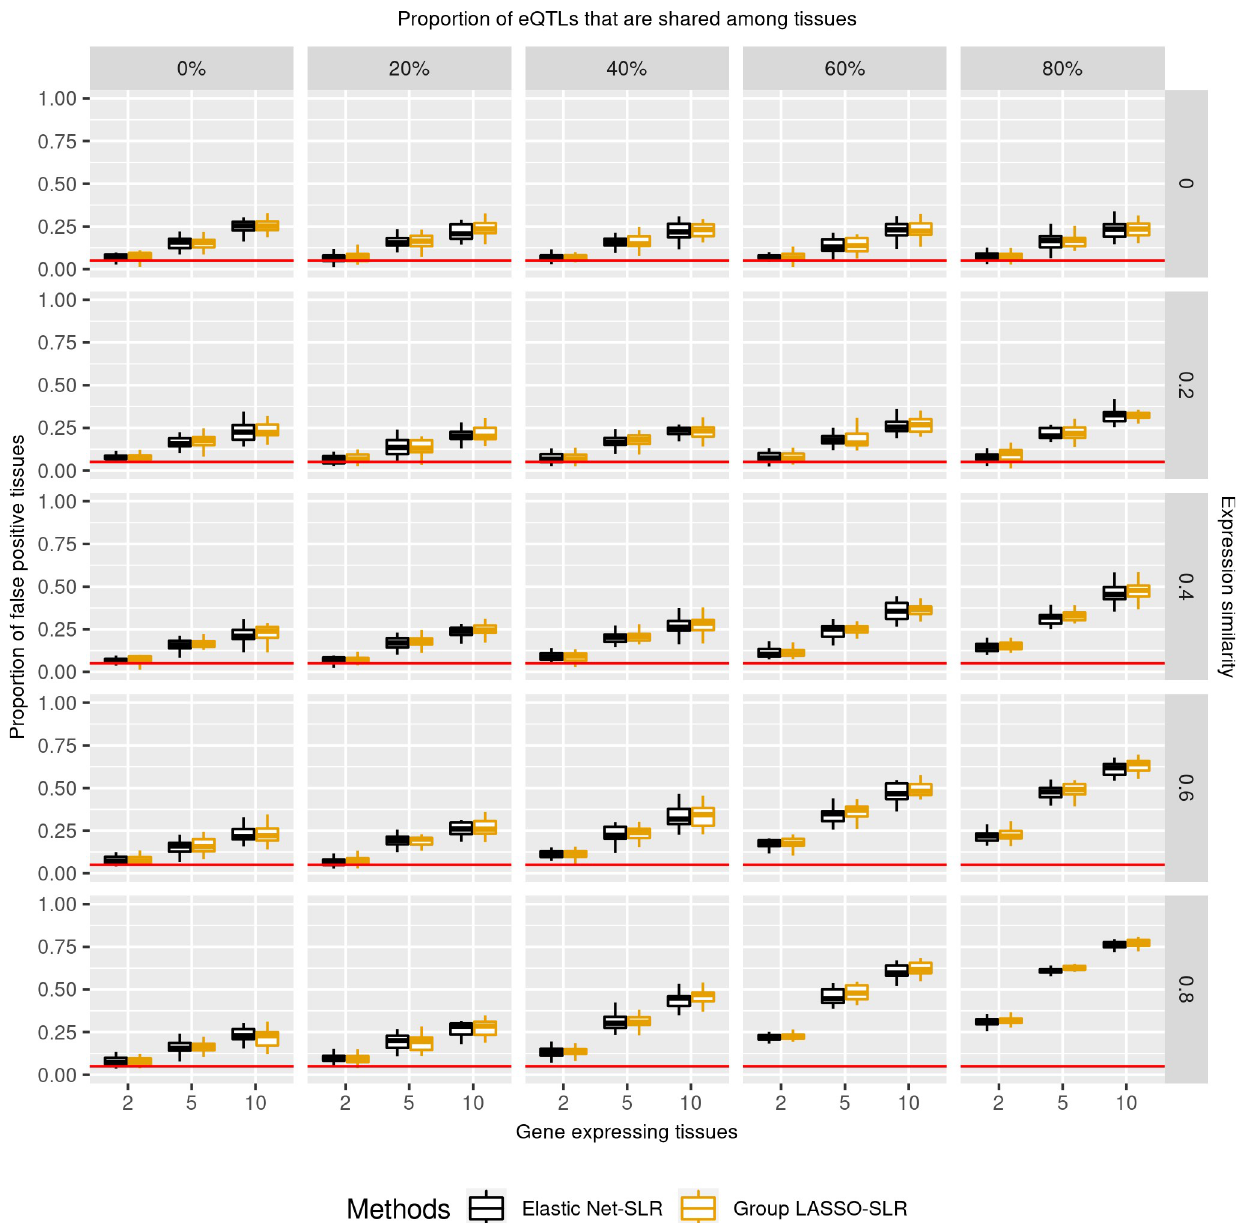
Fig 4. False positive rates of tissues among statistically significant results. False positive rates were the proportion of significant associations found in trait-irrelevant tissues amongst all significant results. Association p-values were controlled for the number of genes and tested tissues. X-axis is the number of gene-expressing tissues. Each column stands for the proportion of eQTLs that are shared among tissues for a gene. Each row is the similarity of gene expression profiles across tissues which is estimated by correlation. Moving from the top left to the bottom right is a gradient spectrum from tissue-specific genes to broadly expressed genes. Colors represent different TWAS methods and y-axis is the false positive rate of tissues among statistically significant results. Single-tissue TWAS wrongly identified 5% and 77% trait-irrelevant tissues for tissue-specific genes and broadly expressed genes,